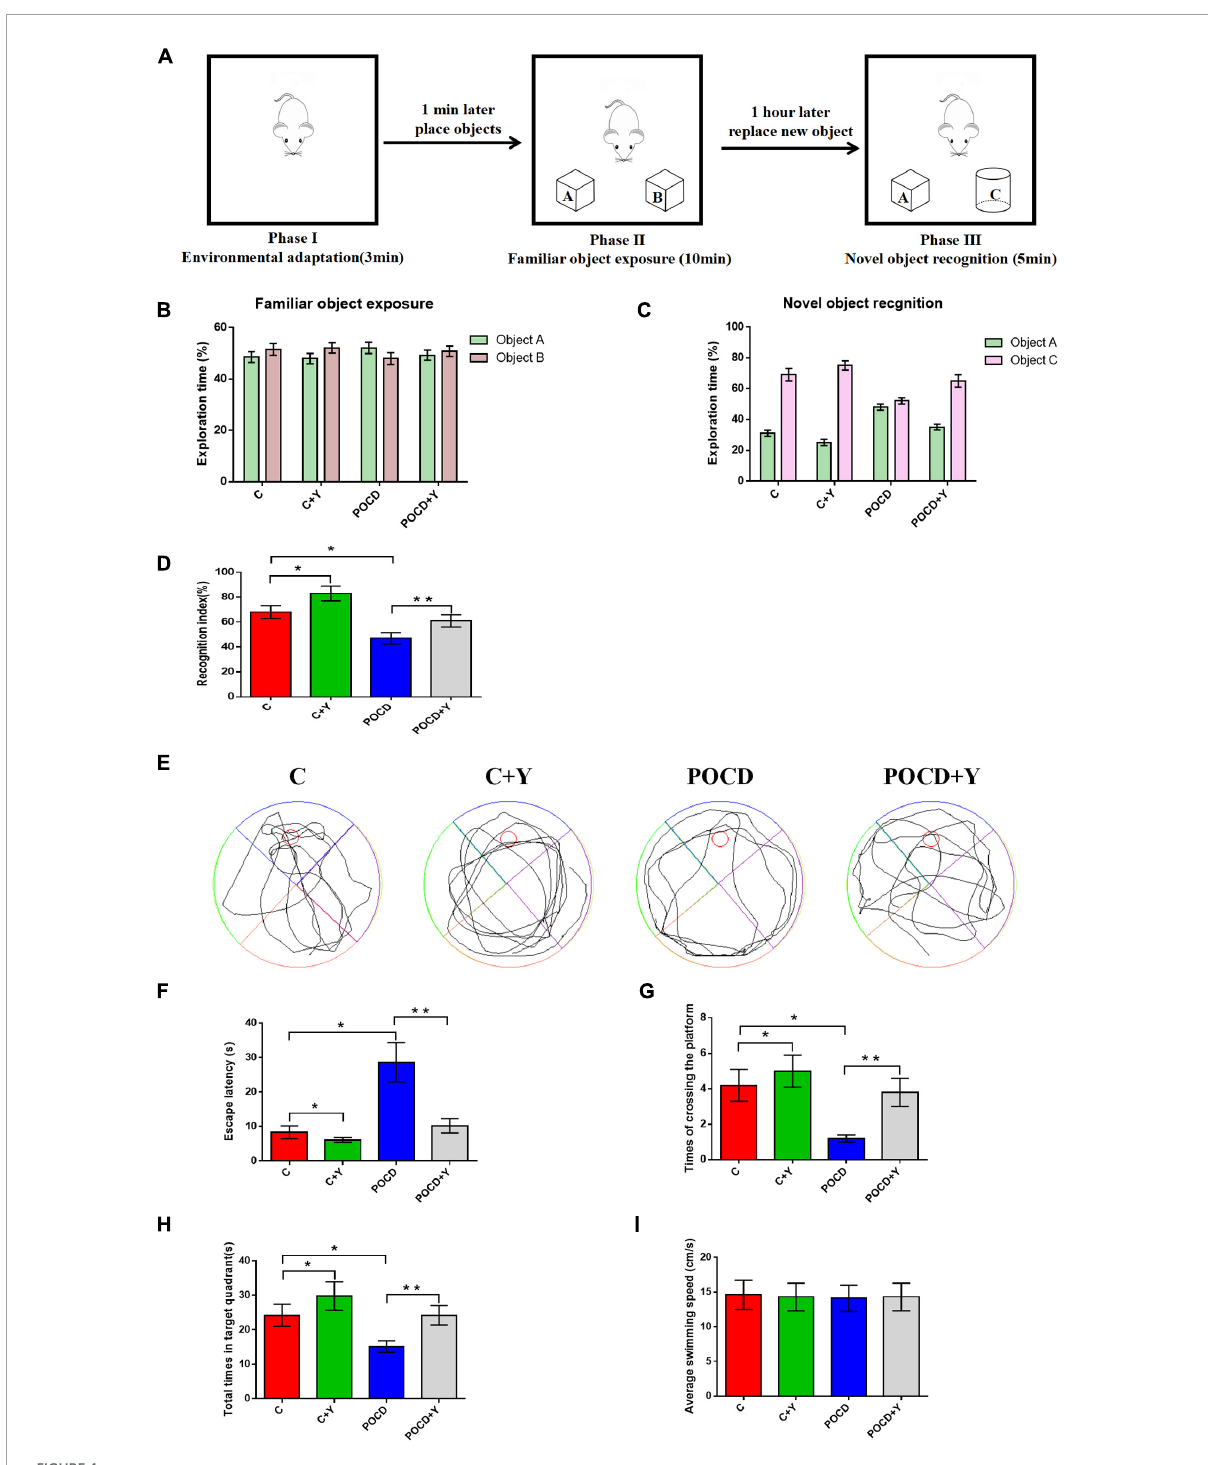
FIGURE4 Young plasma alleviated anesthesia- and surgery-induced postoperative cognitive dysfunction (POCD) in aged rats. (A) Schematic of the novel object recognition test (NORT). (B) Exploration time to the familiar object. (C) Exploration time to the familiar and novel objects during the novel object recognition phase. (D) Recognition index. (E) Swimming trajectory. (F) Escape latency. (G) Times of crossing the platform. (H) Total times spent in the target quadrant. (I) Average swimming speed. Data are shown as means ± standard deviations. * p < 0.05 compared with group C, ** p < 0.05 compared with group POCD ( n = 30 per